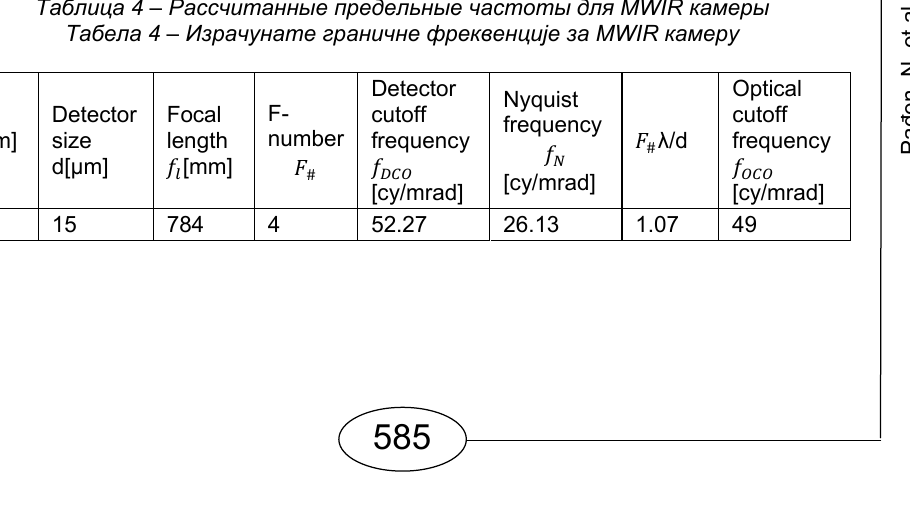
Table 4 ‒ Calculated cutoff frequencies for the MWIR